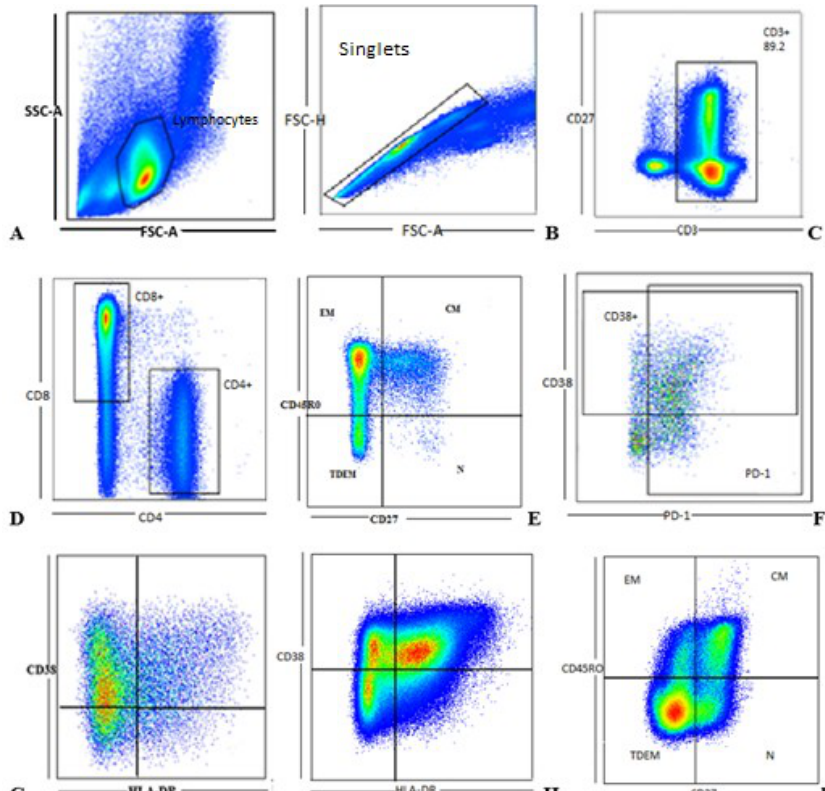
Figure 1. Gating strategy: Flow cytometry analysis of cryptococcal-specific CD4 + and CD8 + T cell memory and phenotypes evaluated in a 6 h assay: ( A ) We first used a singlet gate to exclude doublets by gating on forward scatter-area (FSC-A) against forward scatter-height (FSC-H). ( B ) Lymphocytes were then selected using a forward scatter-area (FSC-A) against side scatter-area (SSC-A) gate. ( C ) Conventional T cells were selected by gating on CD3 + cells from the total lymphocyte population, which were further divided to ( D ) CD4 + and CD8 + T cells. Memory phenotypes were assessed by variable expression of CD45R0 and CD27 on the CD4 + ( E ) and CD8 + ( I ) T cell populations; while T cell activation was assessed by expression of CD38 and HLA-DR on the CD4 + ( G ) and CD8 + ( H ) T cell subsets. T cell exhaustion was assessed by expression of PD-1 ( F ) on both populations. CM represents cryptococcal meningitis.